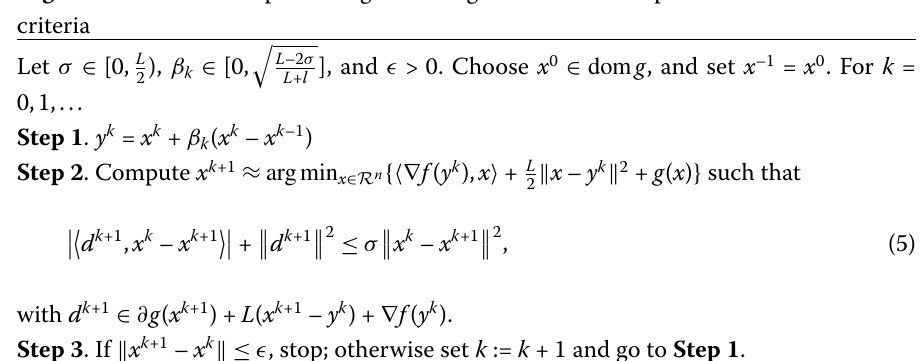
Algorithm 1 An inexact proximal gradient algorithm with extrapolation and relative error